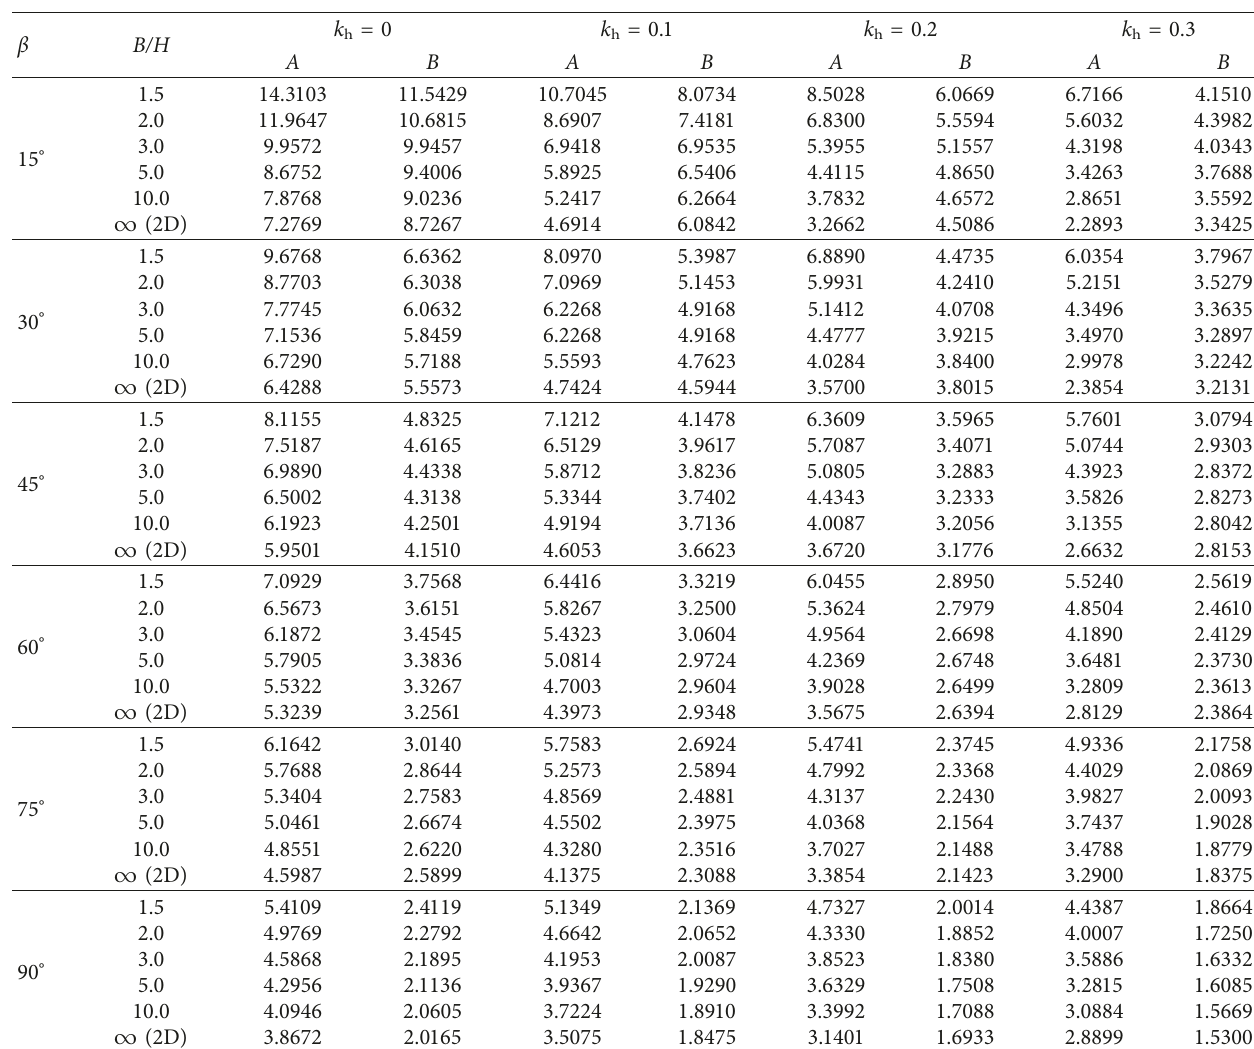
Table 2: Coefficients A and B in equation (12) for cut